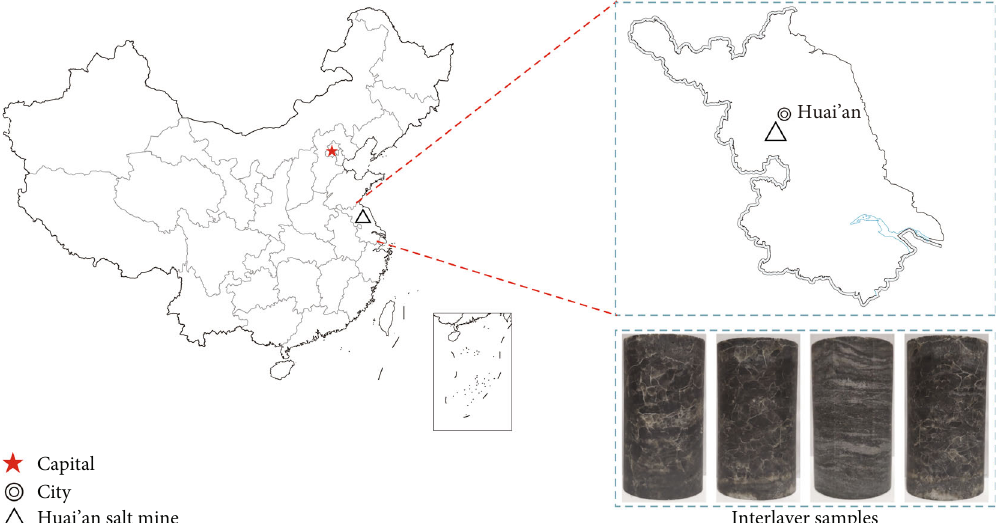
Figure 2: Location of the sample